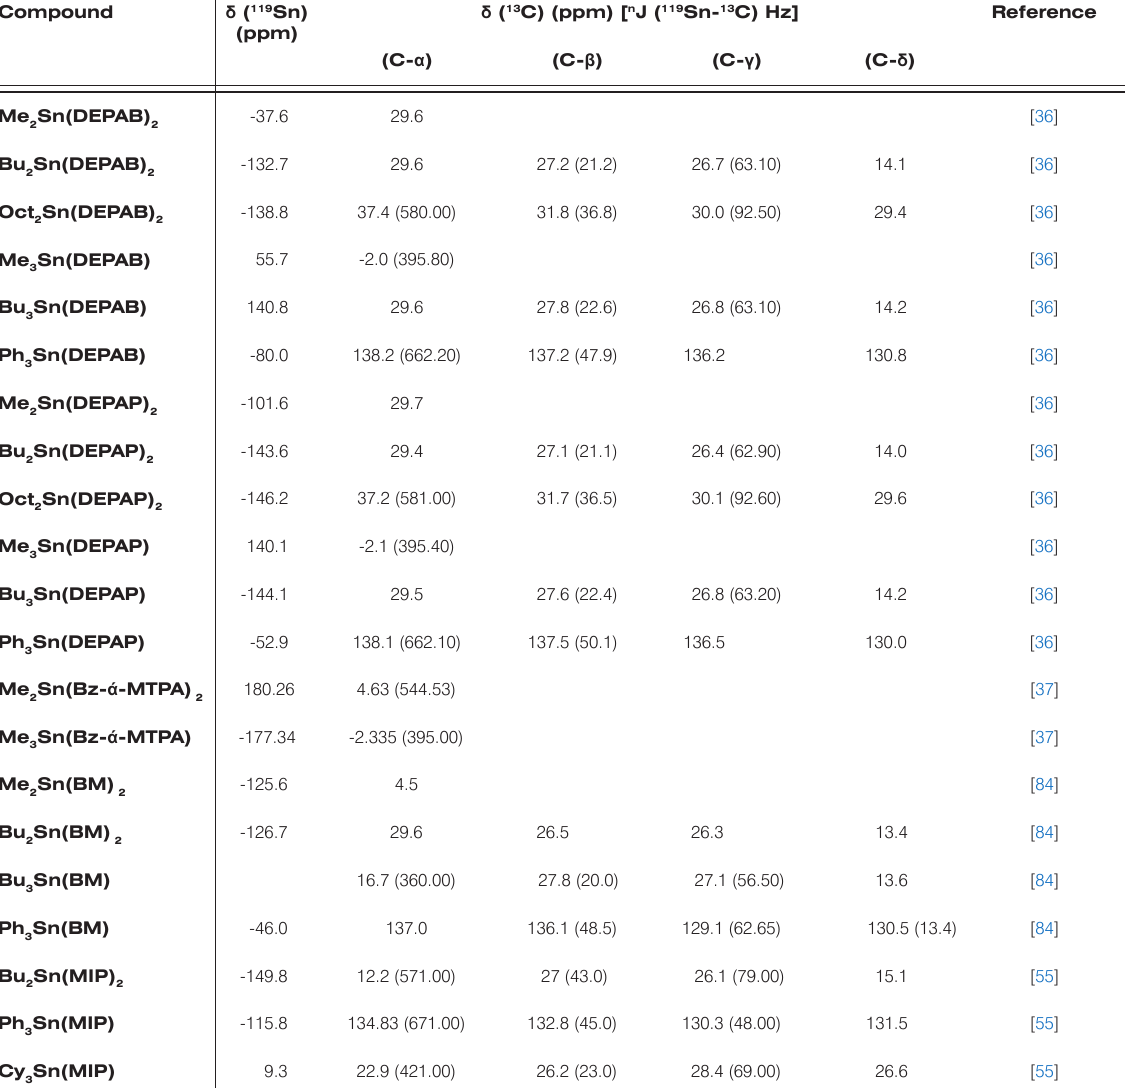
Table 2. 13 C- and 119 Sn-NMR data of di- and triorganotin carboxylates.